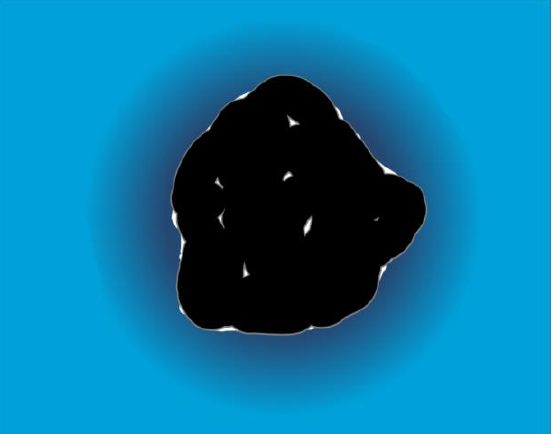
Figure 3. Volume contributions of a folded macromolecule. Black is the volume of the atoms; the cavities are shown in white. The thermal volume is gray. Dark blue indicates the hydration shell, which has higher density compared to the bulk water (light blue).